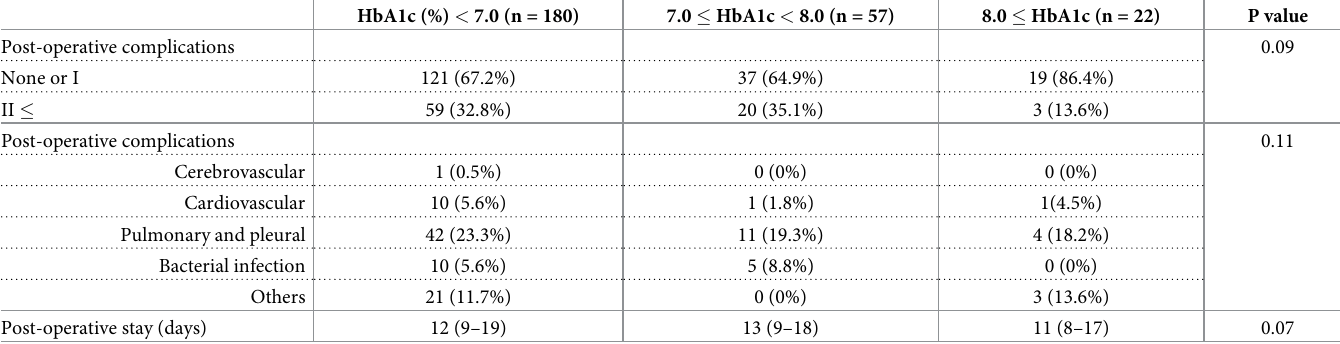
Table 2. Post-operative stay and complications of DM patients stratified by HbA1c